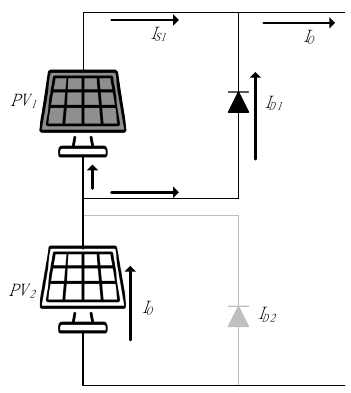
Figure 3. The current flow under shading conditions.